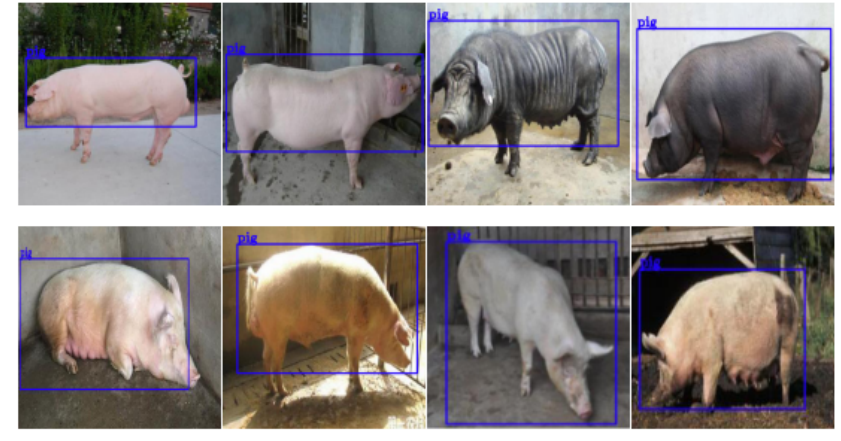
Fig. 7 The results of individual pig